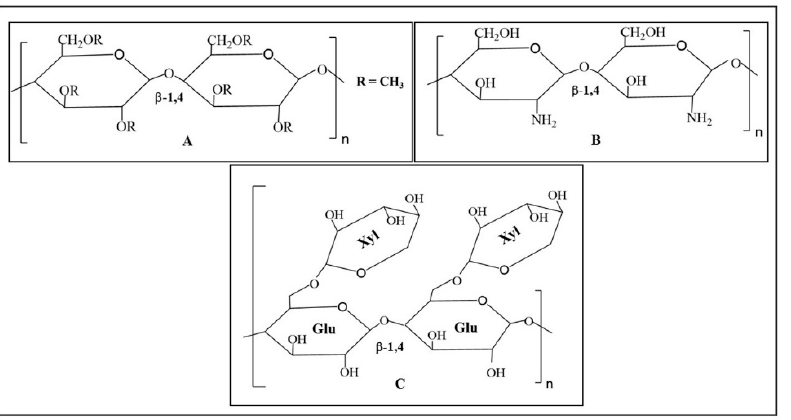
Figure 4. The chemical structures of thermo-responsive polysaccharides: ( A ) methylcellulose (water-soluble derivative of cellulose); ( B ) chitosan; and ( C ) xyloglucan. The chemical structures of the compounds are drawn using ChemDraw Prime software.